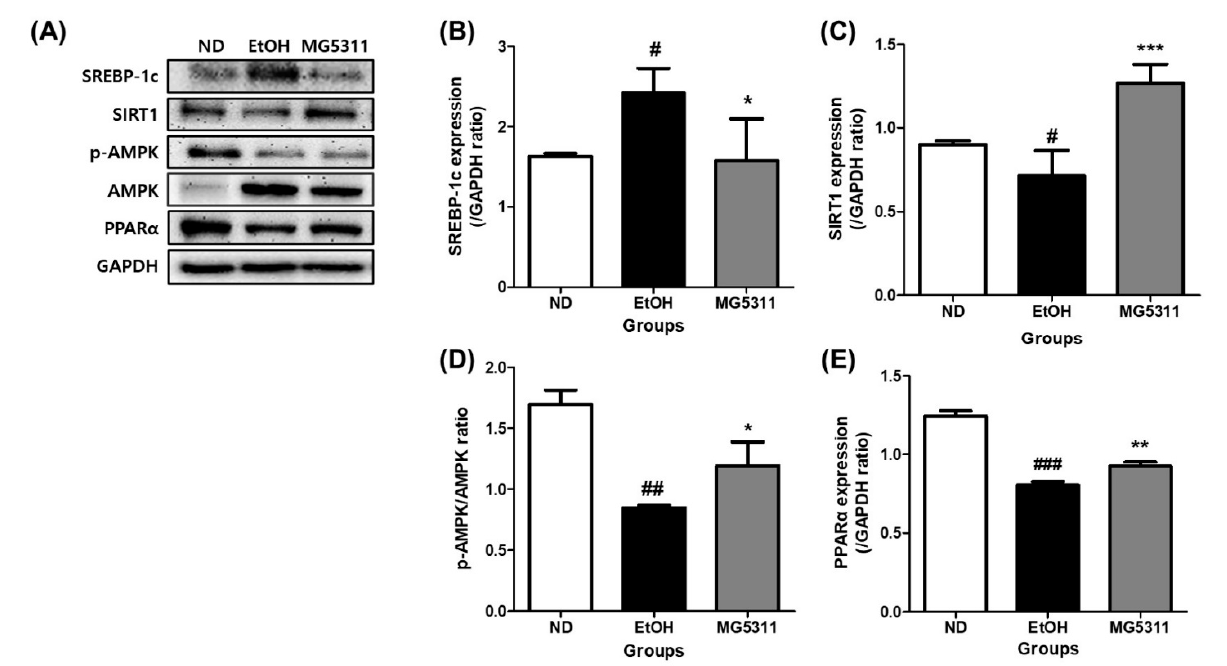
Figure 7. Effect of L. brevis MG5311 on hepatic steatosis-related gene expression in liver tissues of ethanol-fed mice. ( A ) representative Western blot; ( B ) sterol regulatory element-binding transcrip- tion factor 1c (SREBP-1c); ( C ) sirtuin 1 (SIRT1); ( D ) phospho-AMP-activated protein kinase/AMP- activated protein kinase (p-AMPK/AMPK) ( E ) peroxisome proliferator-activated receptor α (PPAR α ). Data are presented as mean ± SD ( n = 3). Significance was analyzed by Dunnett’s test. # p < 0.05, ## p < 0.01, ### p < 0.001 vs. ND group. * p < 0.05, ** p < 0.01, *** p < 0.001 vs. EtOH group. ND, normal diet group; EtOH, ethanol diet group; MG5311, ethanol diet- L. brevis MG5311 administered group.